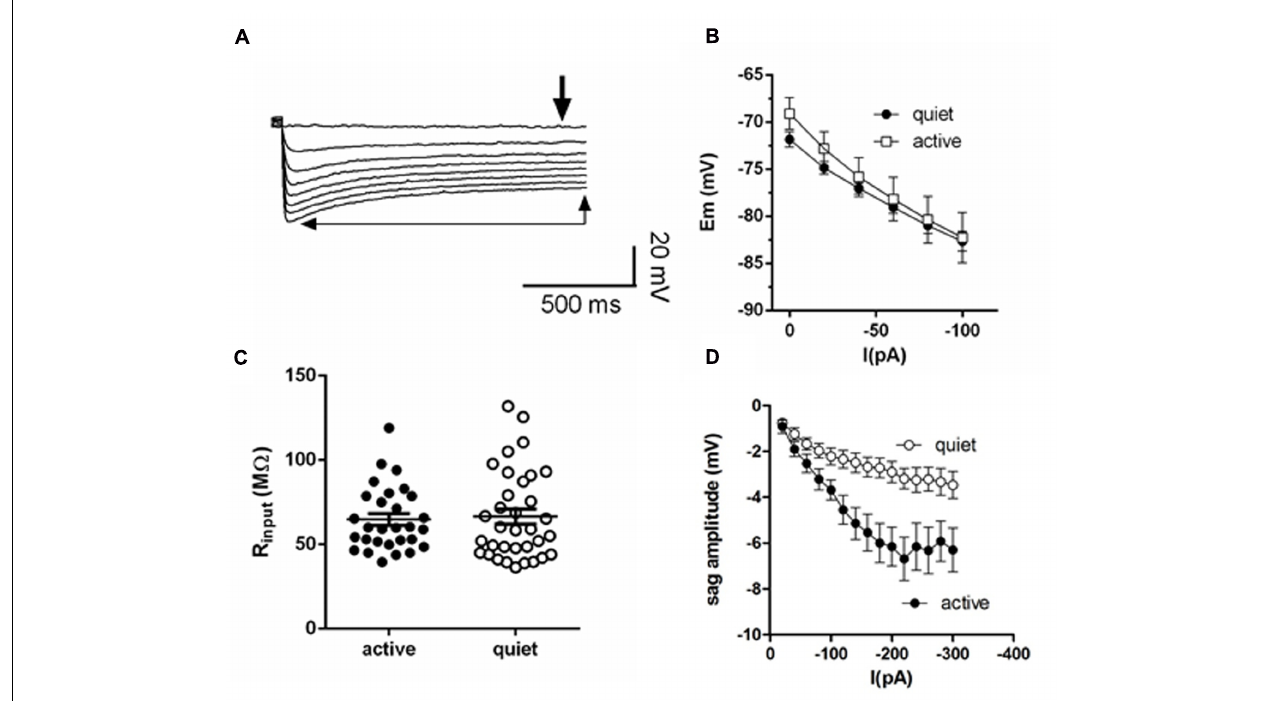
FIGURE 1 | Membrane input resistance is similar in quiet and active fusiform neurons. (A) Example of the membrane response of a fusiform neuron to hyperpolarizations. The thick arrow shows the point where we measured the membrane potential used to calculate membrane input resistance. The thin arrows show the steady-state level of the membrane potential used to calculate the depolarization sag of the membrane. (B) Graph showing the steady-state response of the membrane potential to injected negative DC current in quiet ( n = 16) and active ( n = 14) fusiform neurons. (C) Summary of the membrane input resistance obtained by the linear regression of the data in (B) . (D) Graph showing the dependence of the membrane sag amplitude to the current injected. n = 15 each.